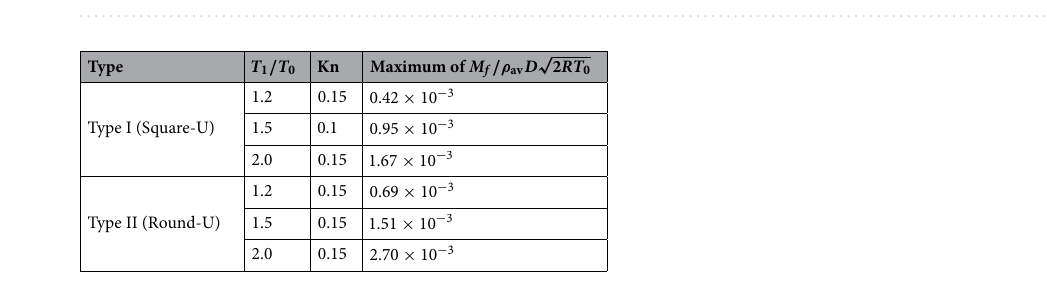
Figure 9. Mass flow rate M f in the x 1 direction per unit length in x 3 as a function of the Knudsen number Kn 1.2 , 1.5, and 2 ( H / D = 2 , L / D 1 ). ( a ) Square-U type, ( b ) round-U type. The symbols in the cases of T 1 / T 0 = = represent the numerical results, which are joined by the line segments.